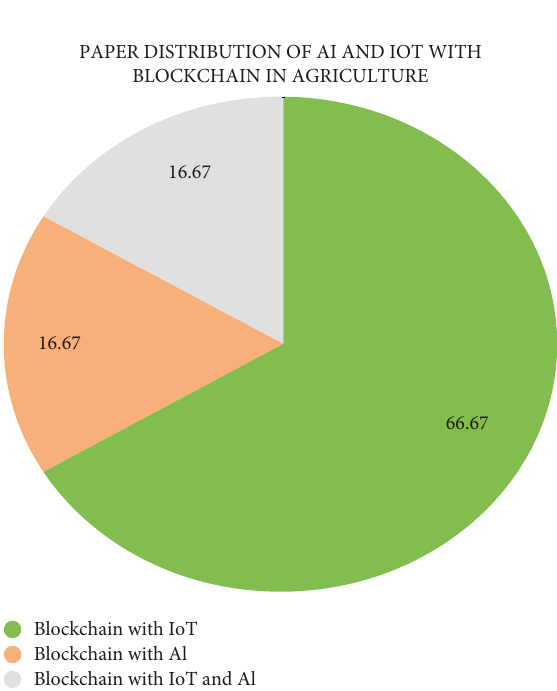
Figure 2: Distributions of papers.